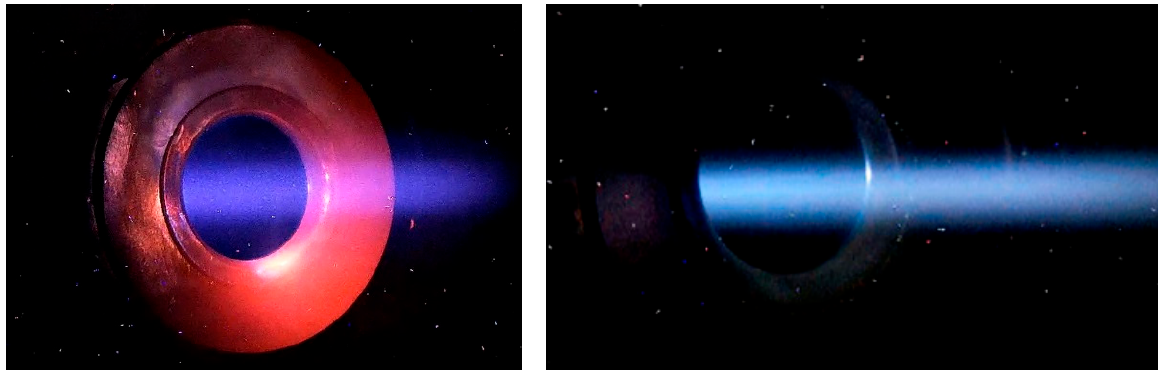
Figure 2. Example of video camera images (the ion beam is visible in blue, the heated diaphragm is visible in red; the image at a proton current of 9 mA is on the right).